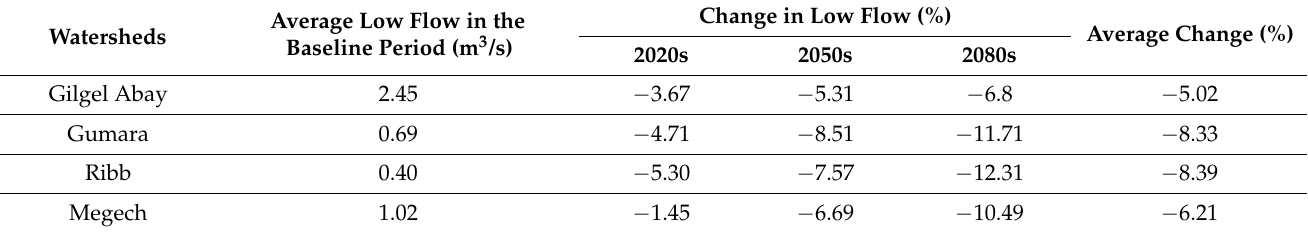
Table 6. Impacts of climate change on low flow of